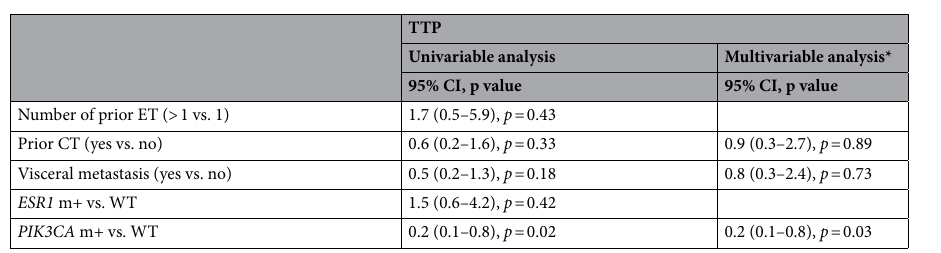
Table 3. Cox analysis for time to progression (TTP) of EverX treatment after enrollment. EverX exemestane + everolimus, CI confidential interval, ET endocrine therapy, CT chemotherapy, WT wild type. *Adjusted with prior chemotherapy, visceral metastasis, and PIK3CA mutation.